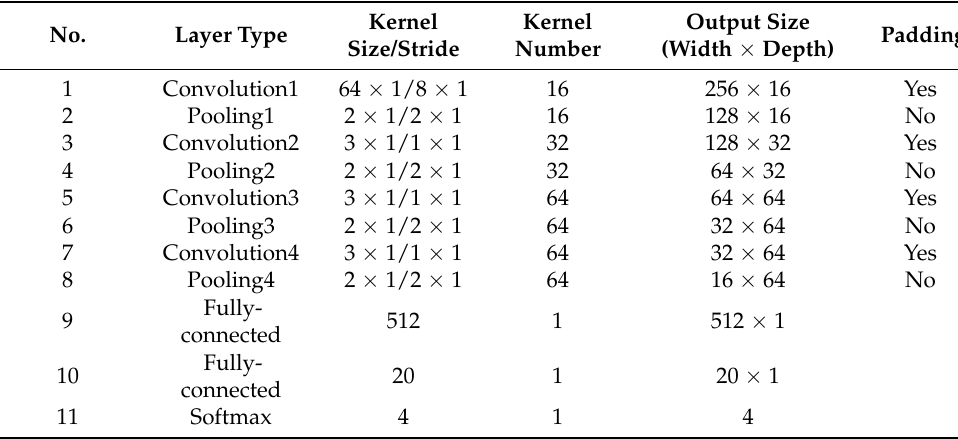
Table 2. Details of DCNN model used in